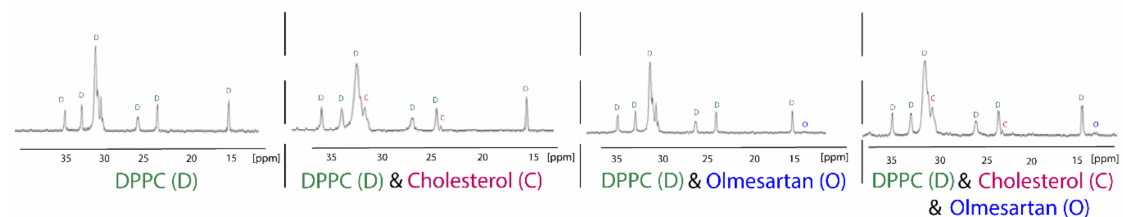
Figure 4. 13 C CP/MAS obtained at liquid crystalline phase of DPPC bilayers (45 ◦ C) of the samples DPPC, DPPC/cholesterol (85:15), DPPC/olmesartan (80:20) and (DPPC/cholesterol)/olmesartan (80:20). 13 C NMR-spectra were obtained at 150.80 MHz with a 600 MHz Varian spectrometer (Palo Alto, CA) and spinning rate 5 kHz. Sample preparation in- volved appropriate amounts of DPPC, olmesartan and cholesterol, diluted in chloroform/methanol mixed, dried under stream of argon and then stored under high vacuum overnight. Approximately 50 mg of the sample packed tightly into a zirconia rotor [35]. Reprinted from Biochimica et Biophysica Acta (BBA)—Biomembranes, 1808, Dimitrios